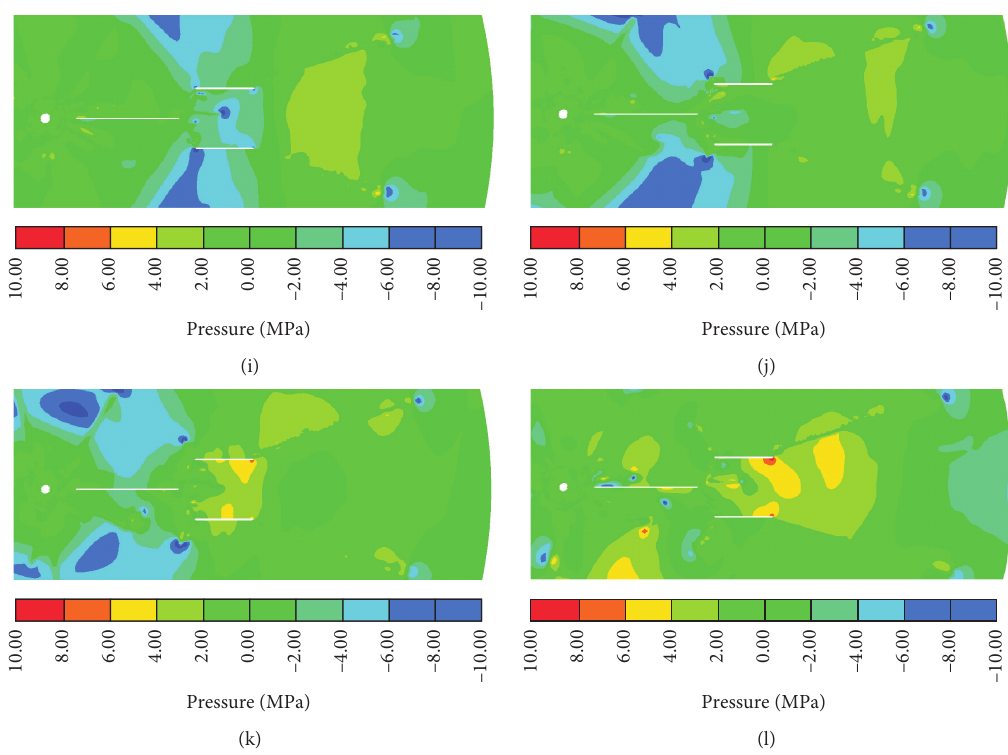
Figure 14: Distribution of pressure during the whole process. (a) t � 4.02 μ s. (b) t � 32.06 μ s. (c) t � 48.22 μ s. (d) t � 74.51 μ s. (e) t � 90.84 μ